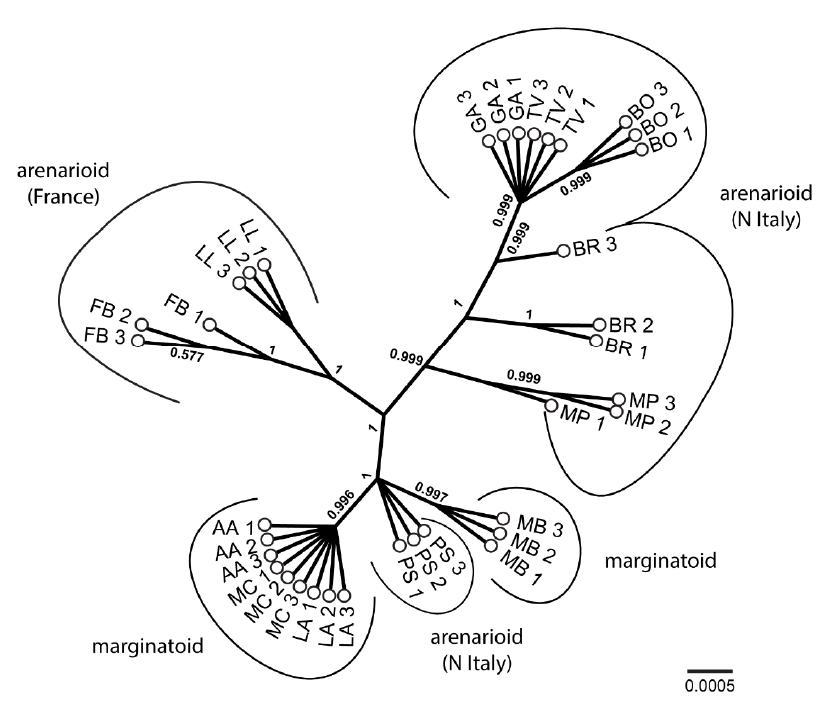
Figure 5. Bayesian unrooted consensus phylogenetic tree (concatenated dataset) of Armeria arenaria populations. AA = Apuan Alps, N Apennines; BO = Bobbio, N Apennines; BR = Brusson, Pennine Alps; FB = Fontainebleau, Île–de–France; GA = Gambolò, West Po Valley; LA = Libro Aperto; N Apennines; LL = Le Lauzet, Dauphiné Alps; MB = Marmagna–Braiola, N Apennines; MC = Monte Cusna, N Apennines; MP = Monte Prinzera, N Apennines; PS = Piana di Salmezza, Lombard Prealps; TV = Terme di Valdieri, Maritime Alps. Further population details are provided in Table 1 and Figure 6.